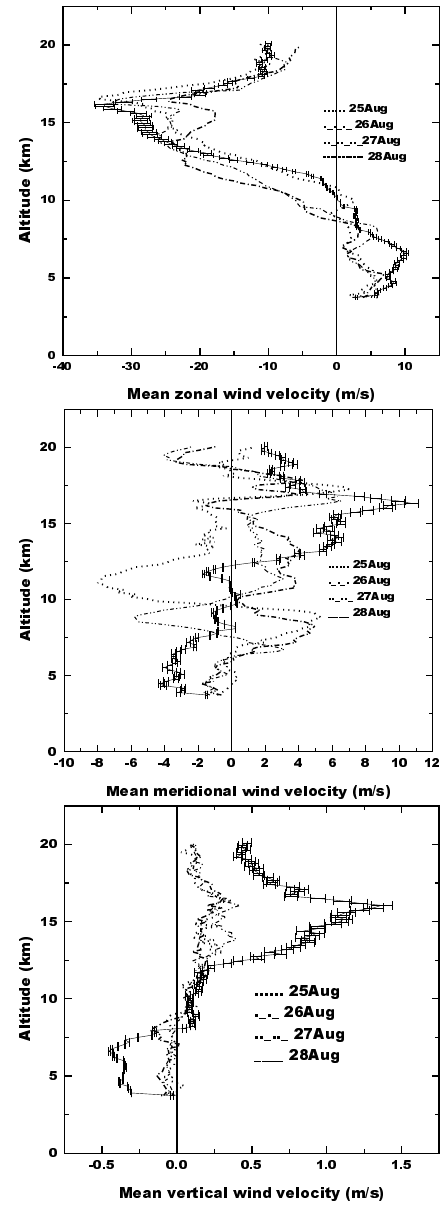
Fig. 1. Mean zonal (top), meridional (middle) and vertical (bottom) wind velocity during 25–28 August 1999.